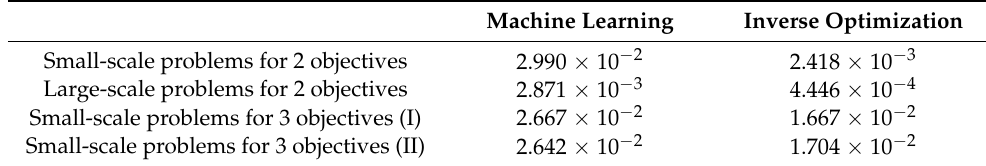
Table 11. MSE result of each case.